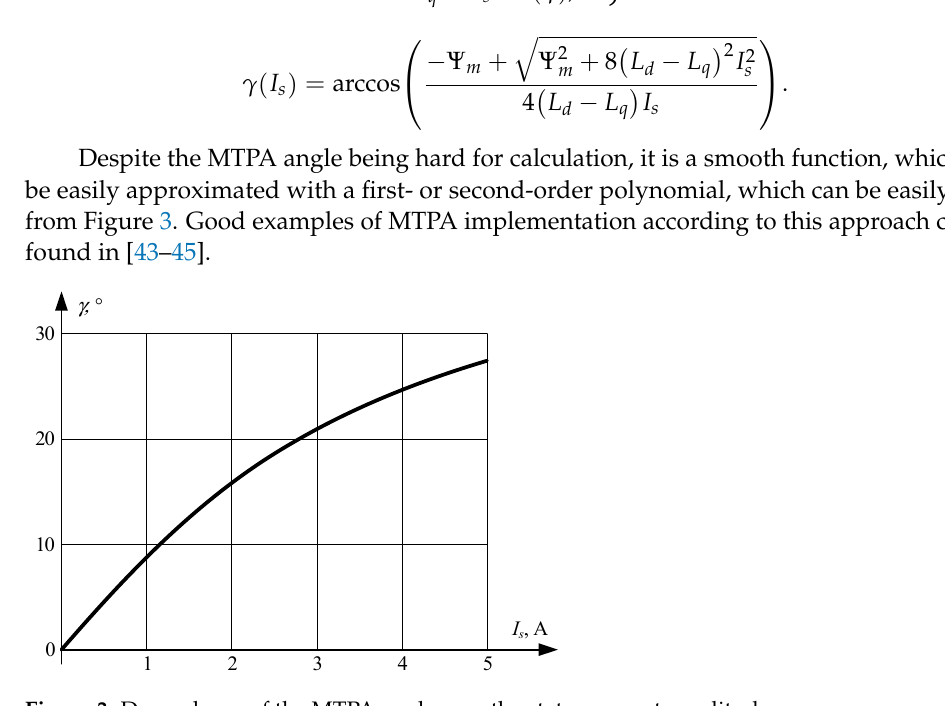
Figure 3. Dependence of the MTPA angle γ on the stator current amplitude.